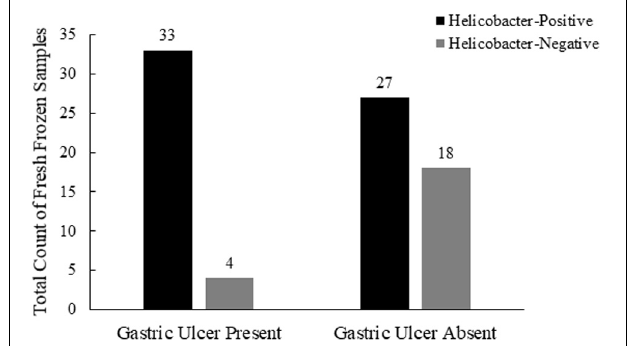
FIGURE 4 | Comparison of southern sea otter Helicobacter spp. infections and postmortem coding of gastric ulcers in the stomach body and pylorus ( n = 82, 10 samples with unknown ulcers removed from this